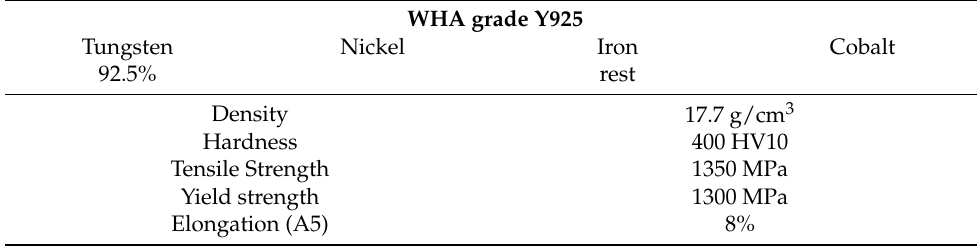
Table 1. Same material parameters of the tested WHA